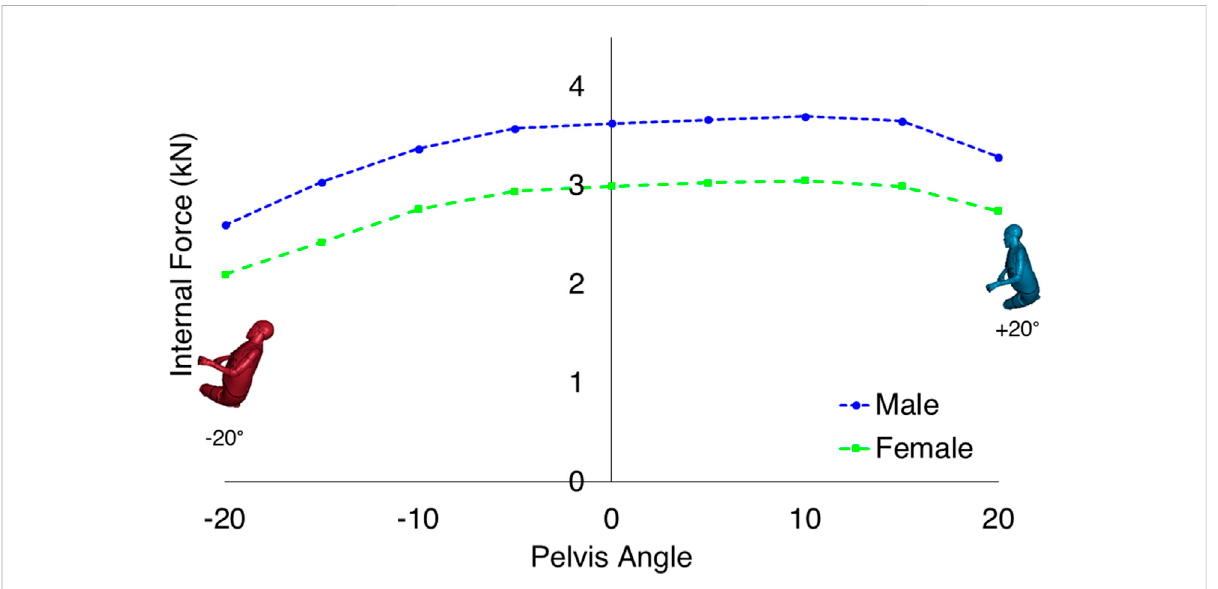
FIGURE 3 Comparison ofthe proximalfemurforces indifferentpelvis angles whenthetrunk angle was fi xedto 10 ° .The proximalfemurforce reaches the maximum value for both sexes at a pelvis angle of +10 °